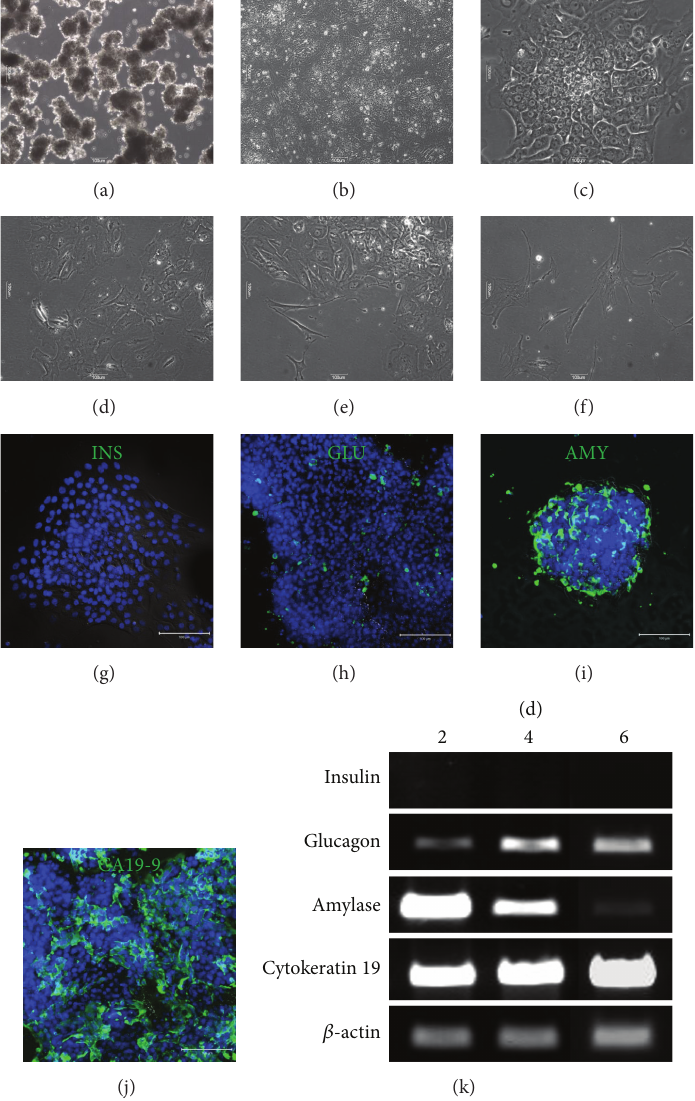
Figure 1: In vitro culture of adult human exocrine pancreas cells. (a) Separated exocrine cells from adult pancreas tissue were suspension cultured on nontissue culture plate for 3 days, resulting in aggregation of single exocrine cells into clusters. (b) Exocrine clusters attached to new tissue culture plates rapidly proliferated into a monolayer. (c) After 3 days of monolayer culturing, the majority of exocrine cells displayed epithelial-like morphology and grew in tight clusters. (d) Increasing culture incubation times resulted in morphology changes in some epithelial-like cells; specifically (e) cells located outside of clusters acquired a fibroblast-like morphology and (f) proliferated alongside the epithelial-like cells. (g) Insulin-positive cells were not detected in epithelial-like exocrine cells at culture day 4; however, (h) glucagon- positive cells were detected. (i, j) A majority of exocrine cells exhibited positive-staining results for amylase and CA19-9. (k) Detection of pancreatic cell markers for insulin, glucagon, amylase, and cytokeratin 19 mRNA in exocrine cells on culture days 2, 4, and 6. Amylase mRNA expression decreased over the culture period and was not observed at culture day 6, whereas cytokeratin 19 mRNA expression was continuously detected up to culture day